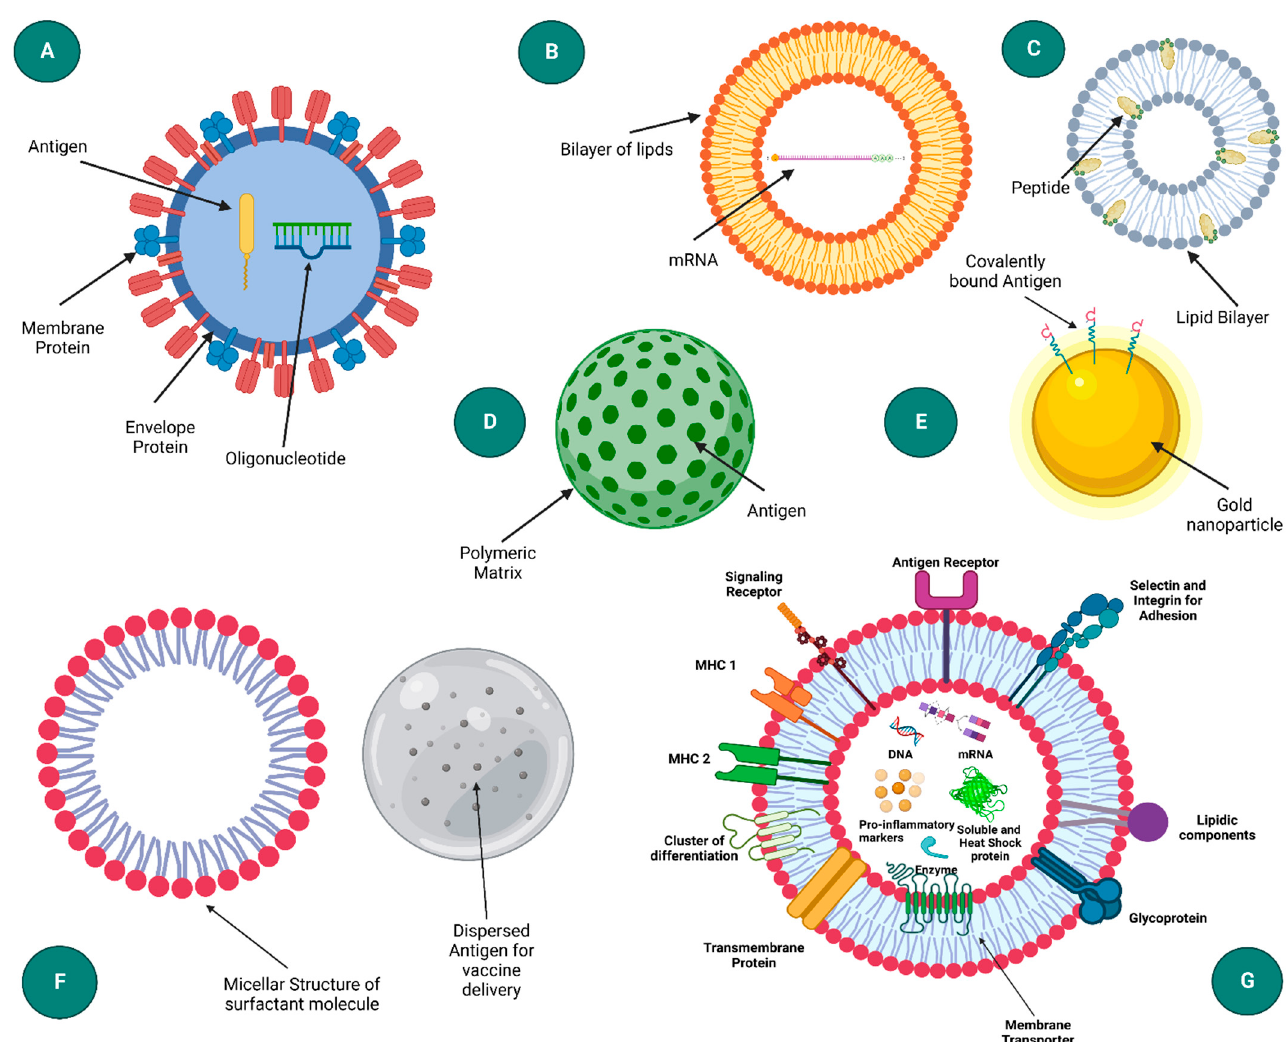
Figure 1. Schematic representation of different nanoparticle based delivery system: ( A ) virus-like particle, ( B ) liposome, ( C ) ISCOM (Immune stimulating complexes), ( D ) polymeric nanoparticle, ( E ) onorganic nanoparticle, ( F ) emulsion, and ( G ) exosome. (Created with Biorender.com (accessed on 28 September 2022)). Table 1. Advantages and disadvantages of different nanoparticles in vaccine delivery.